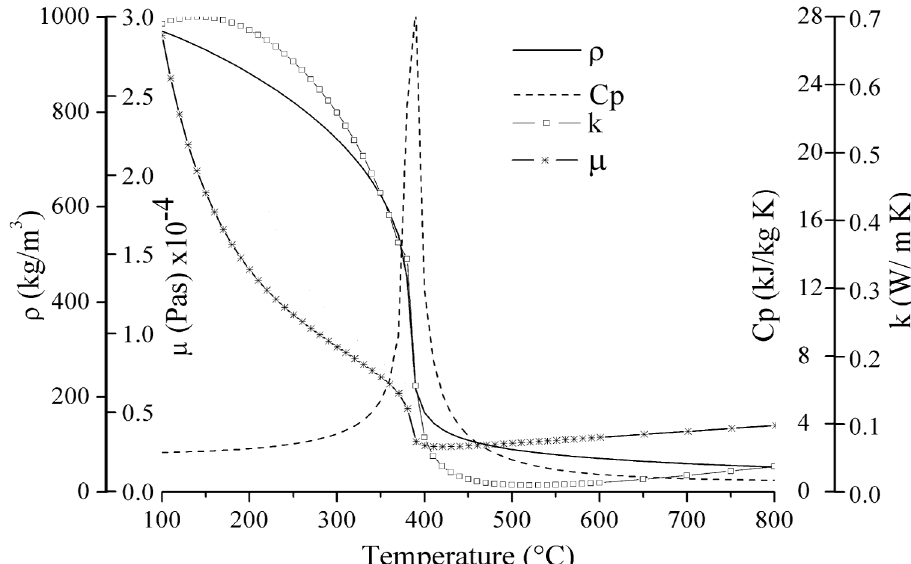
Fig. 3. Behavior of the speci fi c heat ( C p ), thermal conductivity ( k ) and density ( r ), as a function of the temperature at